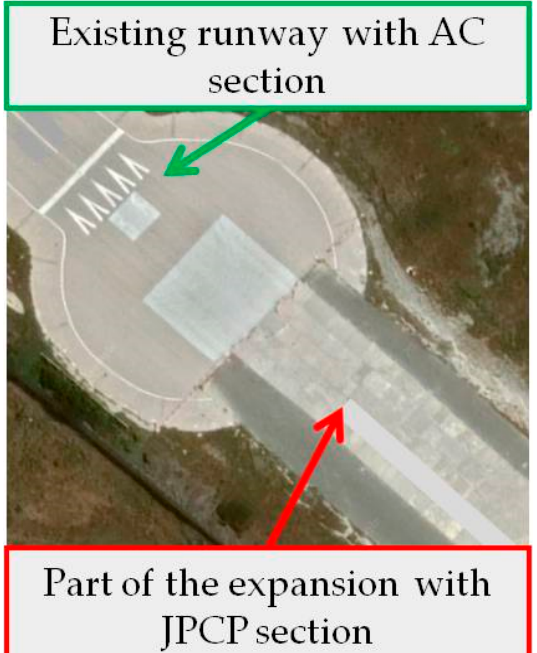
Figure 4. Experimental test site.